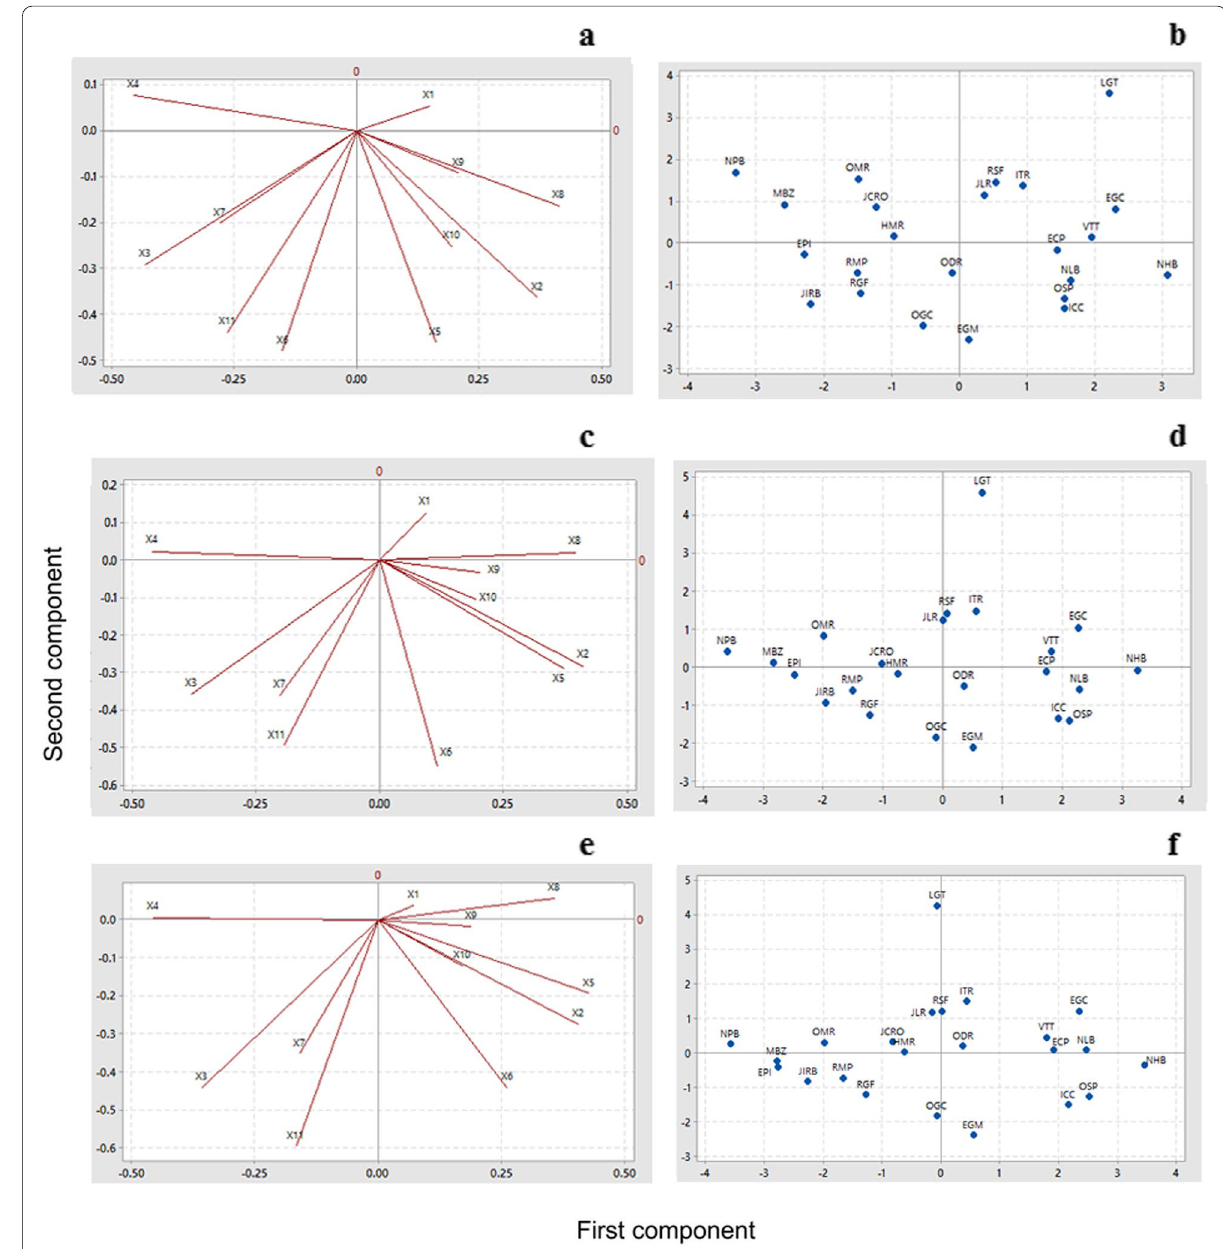
Fig. 1 Projections of the observations in the component plane (graph of the second principal component against the first principal component). ( a ) Influence graphic for R and Xc. ( b ) Score graphic for R and Xc. ( c ) Influence graphic for R/H and Xc/H. ( d ) Score graphic for R/H and Xc/H. ( e ) Influence graphic for R/H 2 and Xc/H 2 . ( f ) Score graphic for R/H 2 and Xc/H 2 . The variables in the influence graphs (Fig. 1a, c, e) represented age (X 1 ), gender (X 2 ), patient weight (X 3 ), H (X 4 ), θ (X 7 ), degree of ECOG functional scale (X 8 ), tumor stage (X 9 ), tumor histological variety (X 10 ), BMI (X 11 ). The variable X 5 symbolized R (Fig. 1a), R/H (Fig. 1c) and R/H 2 (Fig. 1e). The variable X 6 denoted Xc (Fig. 1a), Xc/H (Fig. 1c) and Xc/H 2 (Fig. 1e). In the score graphics were represented the name initial of each patient corresponding to its code showed in Table 1: Code 1 (NPB), Code 2 (OMR), Code 3 (NHB), Code 4 (RSF), Code 5 (LGT), Code 6 (HMR), Code 7 (MBZ), Code 8 (ODR), Code 9 (OGC), Code 10 (JIRB), Code 11 (EGM), Code 12 (EPI), Code 13 (ITR), Code 14 (JRL), Code 15 (VTT), Code 16 (JCRO), Code 17 (RMP), Code 18 (ECP), Code 19 (EGC), Code 20 (NLB), Code 21 (OSP), Code 22 (CPI) and Code 23 (RGF). Patients with initials NHB, OSP, NLB, EGM, ECP, EGC, LGT, ITR, RSF, JLR, ODR, OGC and OMR deceased during the writing of this paper (Fig. 1b, d, f). The patient OMR died by global heart